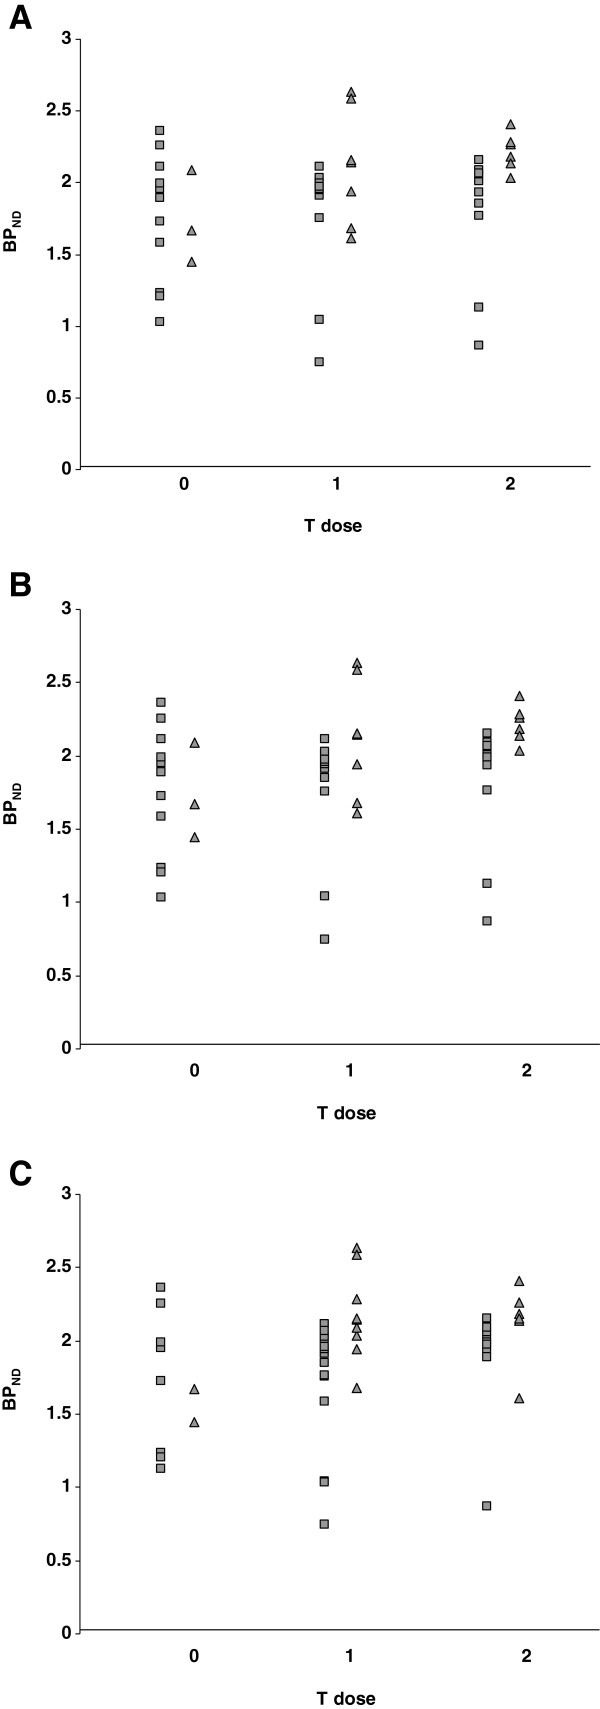
Binding potential (BPND) of (R)-[11C]verapamil. Global BPND in healthy controls (HC, squares) and Alzheimer's disease patients (AD, triangles) as a function of T dose in (A) C1236T, (B) G2677T and (C) C3435T is shown. Mean BPND values and SD are given. (A) C1236T: In HC, BPND values for 0 T, 1 T and 2 T were 1.76 ± 0.45, 1.77 ± 0.45 and 1.79 ± 0.44, and in AD, the values were 1.74 ± 0.33, 2.11 ± 0.37 and 2.22 ± 0.13, respectively. (B) G2677T: In HC, BPND values for 0 T, 1 T and 2 T were 1.76 ± 0.45, 1.76 ± 0.44 and 1.81 ± 0.44, and in AD, the values were 1.74 ± 0.33, 2.11 ± 0.37 and 2.22 ± 0.13, respectively. (C) C3435T: In HC, BPND values for 0 T, 1 T and 2 T were 1.73 ± 0.49, 1.73 ± 0.44 and 1.88 ± 0.39, and in AD, the values were 1.56 ± 0.15, 2.17 ± 0.30 and 2.13 ± 0.27, respectively.